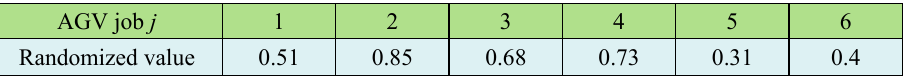
Fig. 3. The randomized AGVs job